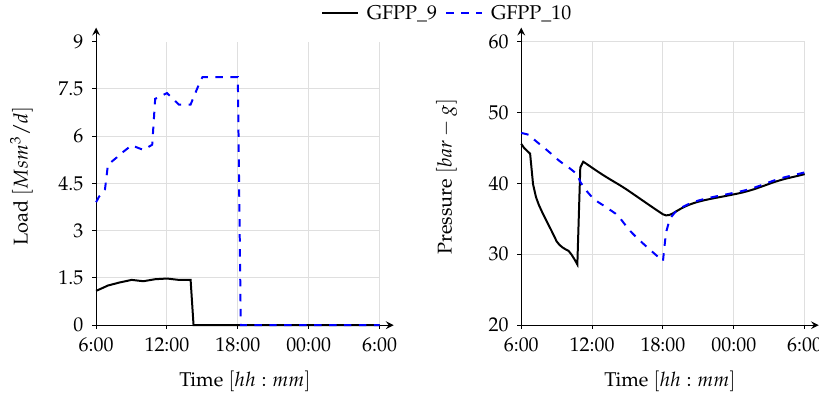
Figure 14. Time evolution of load and pressure of failed GFPPs in scenario 2.